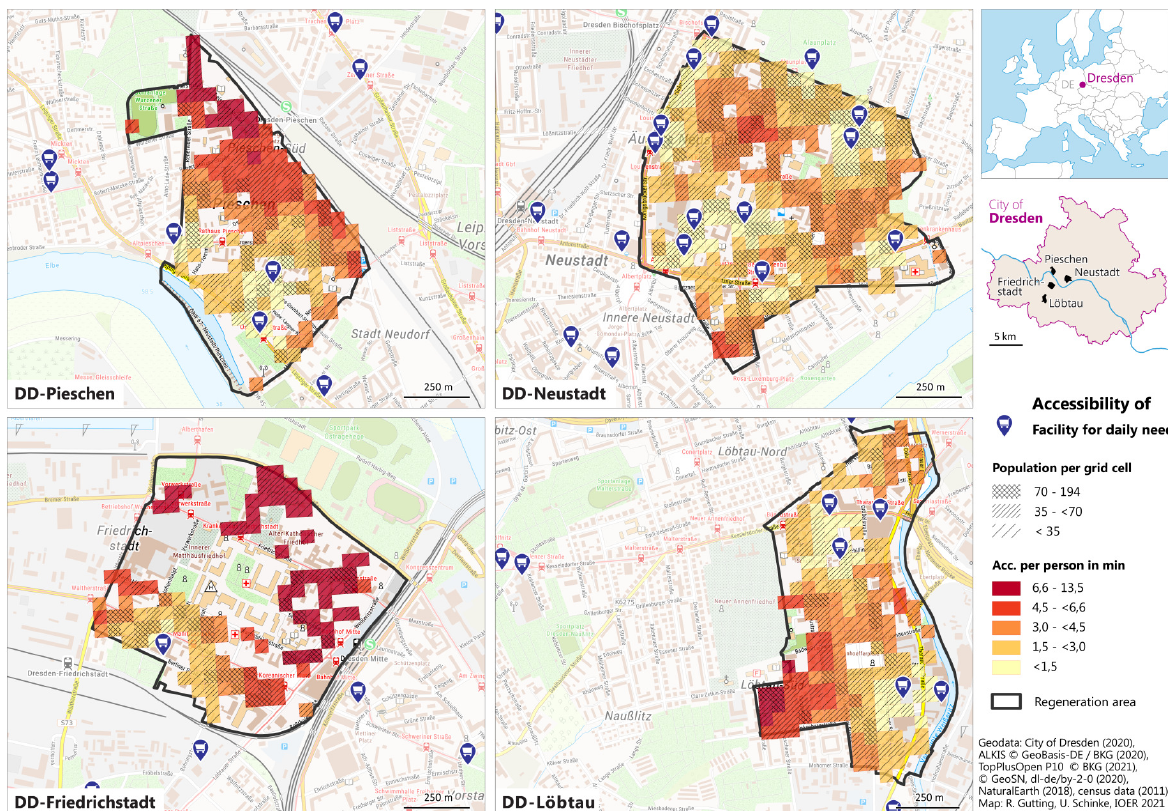
Figure 3. Grid cells showing population density and walking distance in minutes to nearest facility for daily need.